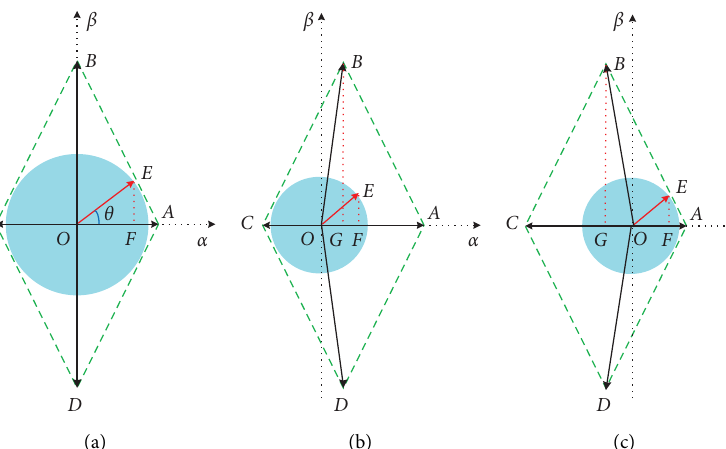
Figure 2: SSVM allocation for FSTPR topology; (a) E